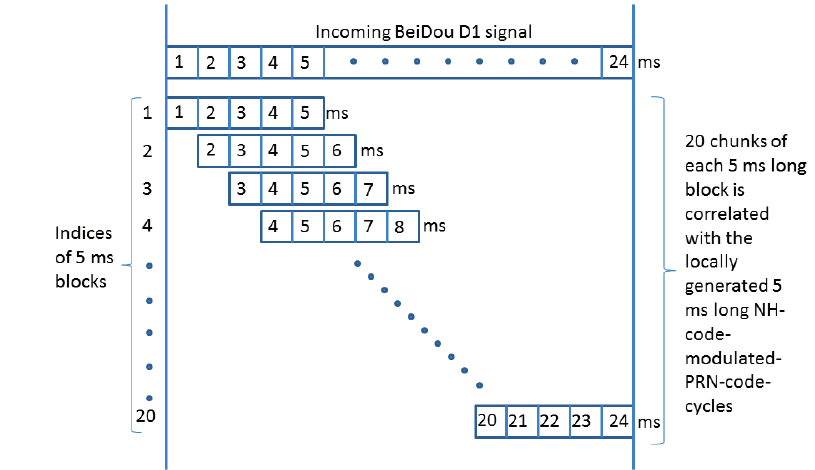
Figure 2. 24 ms long incoming BeiDou signal is structured into 20 chunks of 5 ms long block with an index increment of